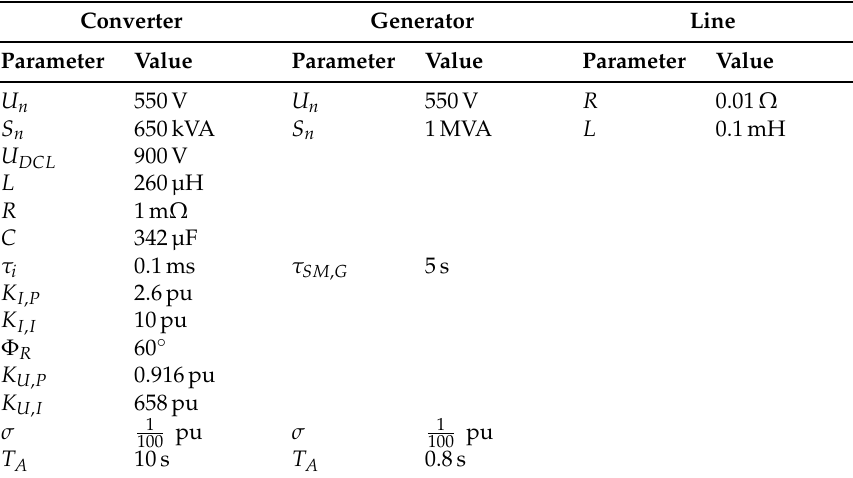
Table 1. Parameters used in the